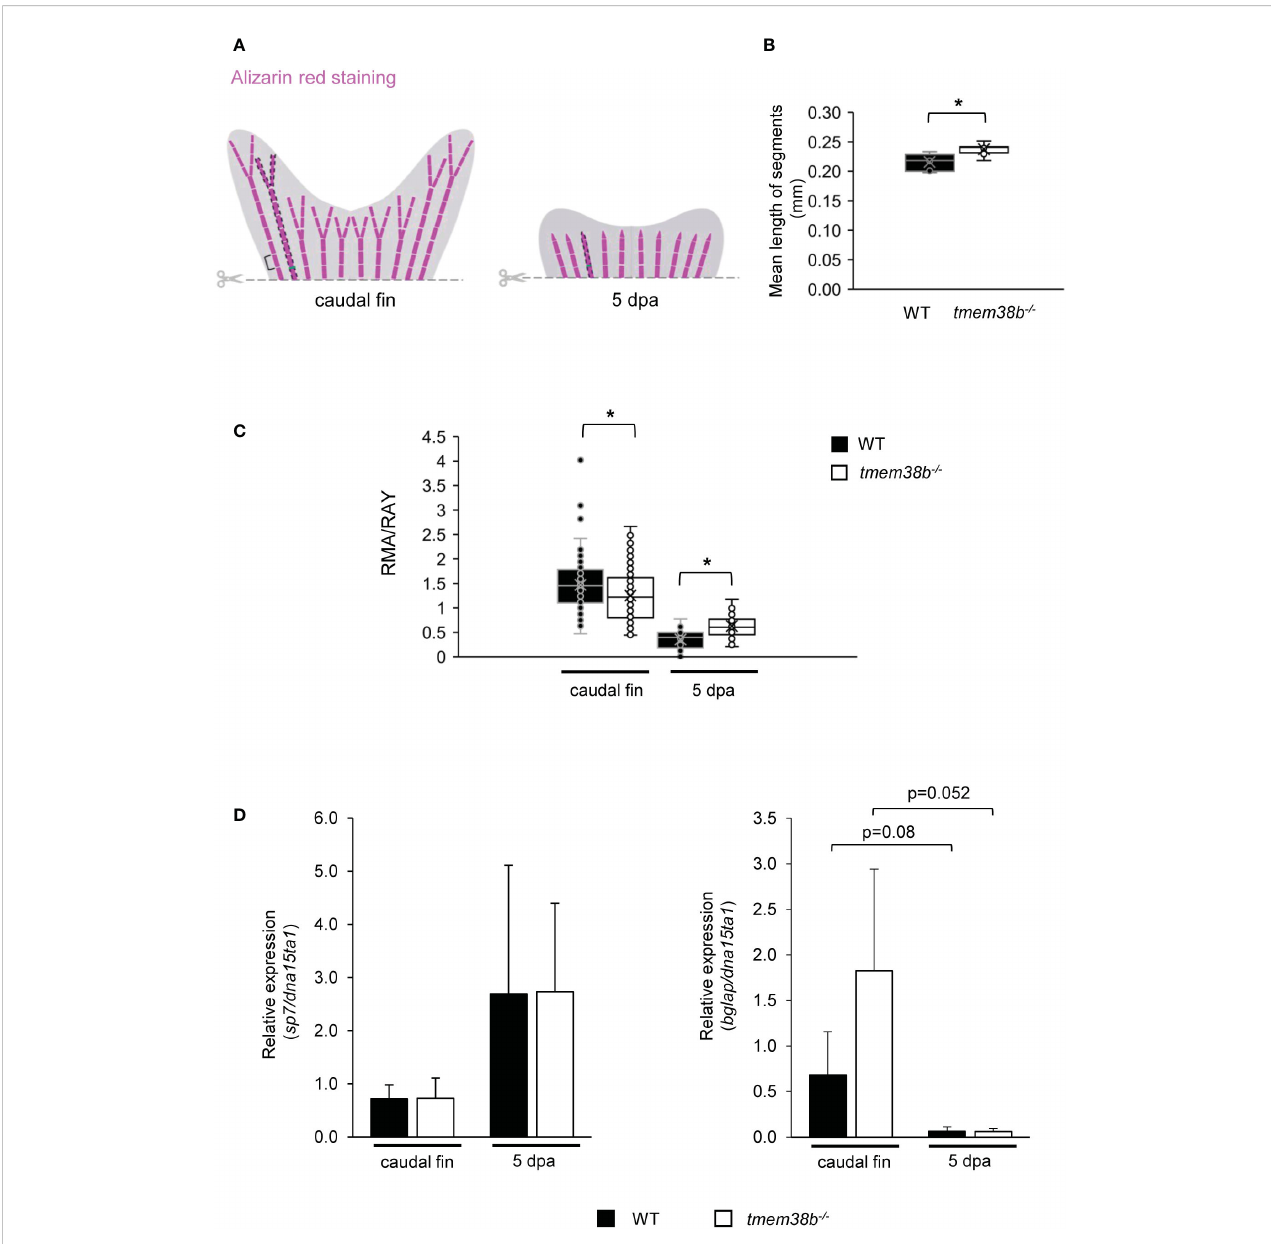
FIGURE 5 Morphometric and bone mineralization analyses during caudal fi n regeneration in WT and tmem38b -/- mutants. (A) Schematic representation of morphometric measurements. Brackets indicate the length of fi n ray segment, dashed areas represent the real mineralized areas (RMA) and the green lines indicate the ray widths (RAY). (B) The mean length of caudal fi n ray segments was evaluated. Segments were signi fi cantly longer in tmem38b -/- compared to WT. (C) The ratio between the real mineralized area (RMA) and the mean ray width (RAY) was measured on alizarin red stained caudal fi ns to assess mineralization level. tmem38b -/- caudal fi n was less mineralized respect to the WT. After 5 dpa, the regenerated mineralized area was larger in tmem38b -/- respect to the WT (WT n ≥ 9, tmem38b -/- n ≥ 8) *p < 0.05. (D) Relative expression of the early ( sp7 ) and late ( bglap ) osteoblastic markers in WT and tmem38b -/- caudal fi ns in amputated and 5 dpa (WT n = 3, tmem38b -/- n = 3) samples. No signi fi cant difference was detected in sp7 and bglap expression between WT and tmem38b -/- at both time points, even if a trend towards higher value was evident for bglap in mutant caudal fi ns with respect to controls. Data are shown as mean ±